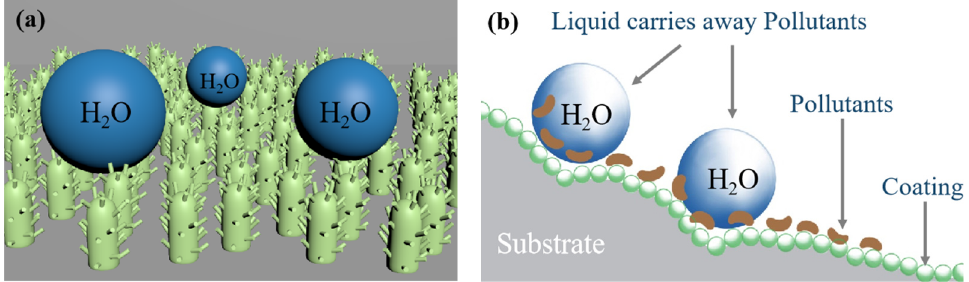
Figure 12. Models. ( a ) Microscopic model of coated surfaces. ( b ) Self-cleaning model of coated surfaces.